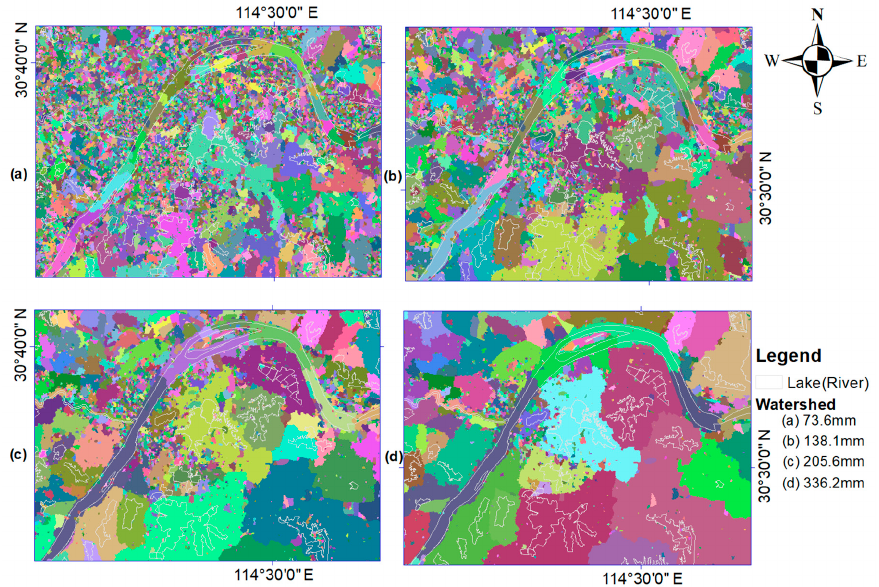
Figure 8. Watershed delimitation according to the flow direction dataset and the merged maps of basic units for certain precipitations. Figure ( a – d ) are the watershed delimitation with precipitations of 73.6 mm, 138.1 mm, 205.6 mm, and 336.2 mm,